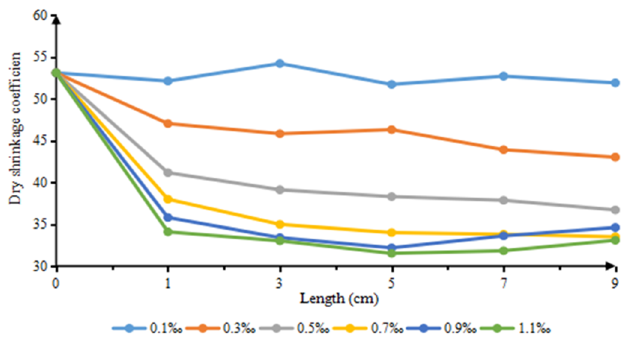
Figure 5. Effects of fiber length on the dry shrinkage coefficient.